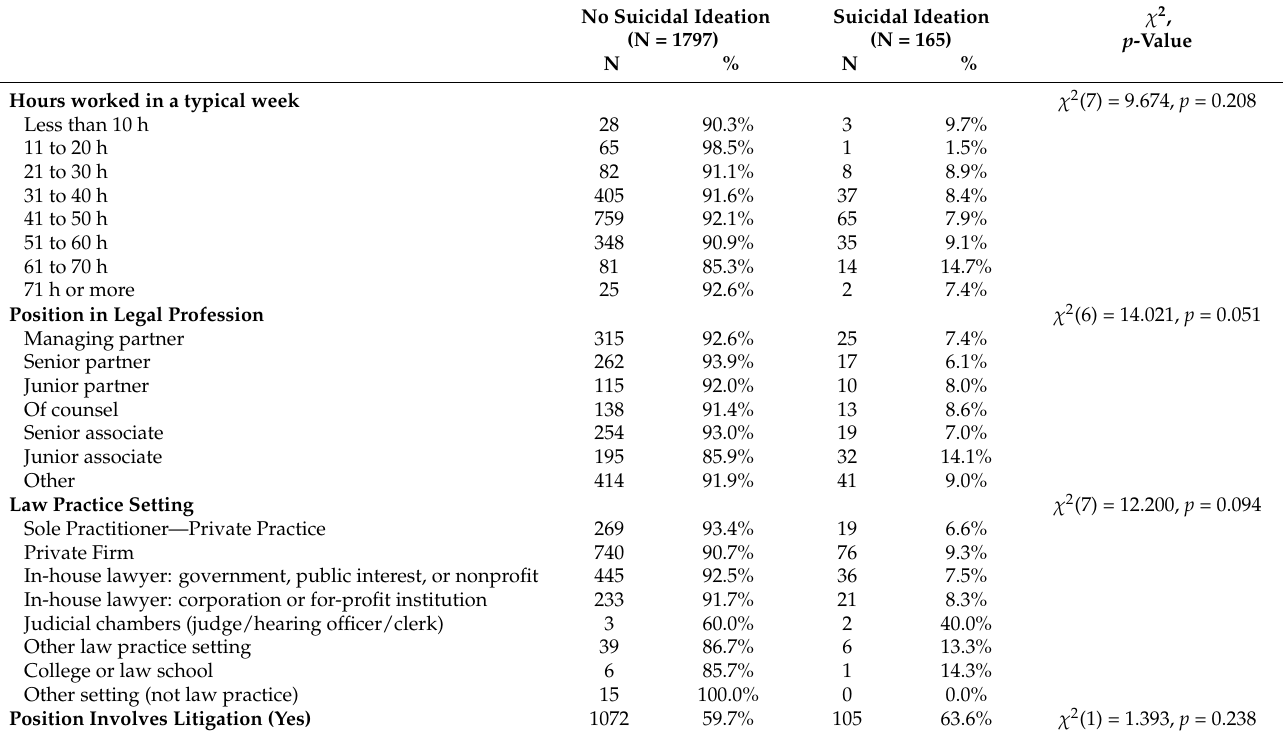
Table 2. Work-related demographics of the study sample according to endorsement of PHQ-9 suicidal ideation (N =